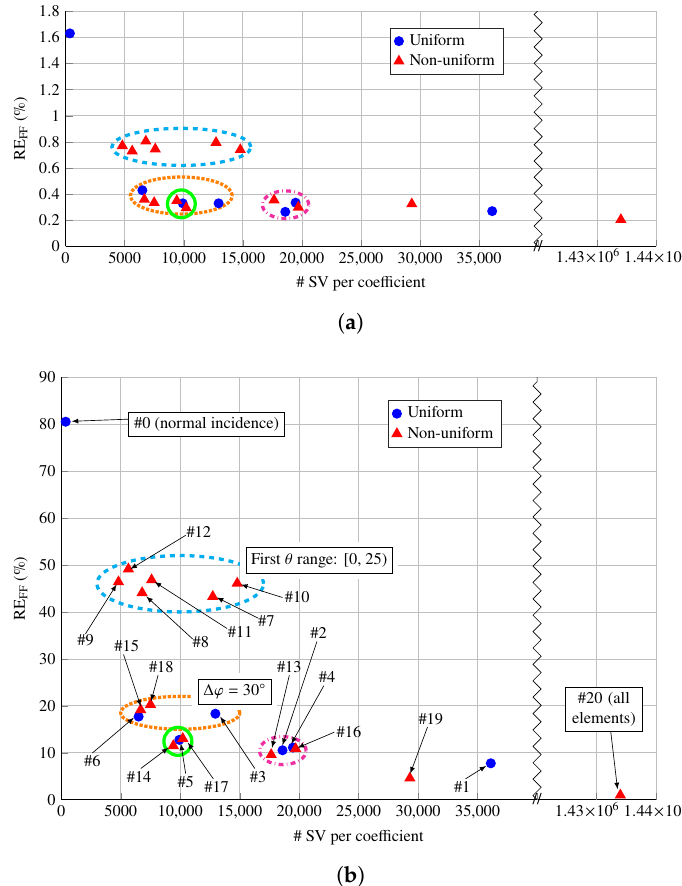
Figure 5. Relative error for the discretizations of the angles of incidence shown in Table 2 for the ( a ) copolar and ( b ) crosspolar patterns. There is a direct correspondence between the samples in both subfigures in the abscissa axis. Clusters of points are grouped in colored ellipses for easy identifications that share some common characteristics: dashed blue are coarse discretizations with a first θ range of 25°; dotted orange are finer discretizations in θ with a step of ∆ ϕ = 30° in ϕ ; solid green are discretizations with a trade-off between relative error and low number of support vectors per coefficients; and dashed dotted pink are discretizations with low error and a moderate number of support vectors per